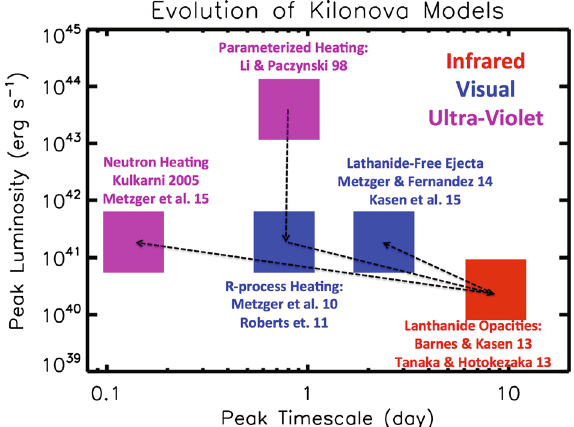
that kilonova emission peaks in the NIR, with the optical emission highly suppressed, has important implications for the strategies of EM follow-up of future GW bursts. The timeline of theoretical predictions for the peak luminosities, timescales, and spectrap peak of the kilonova emission are summarized in Table 1 and Fig.